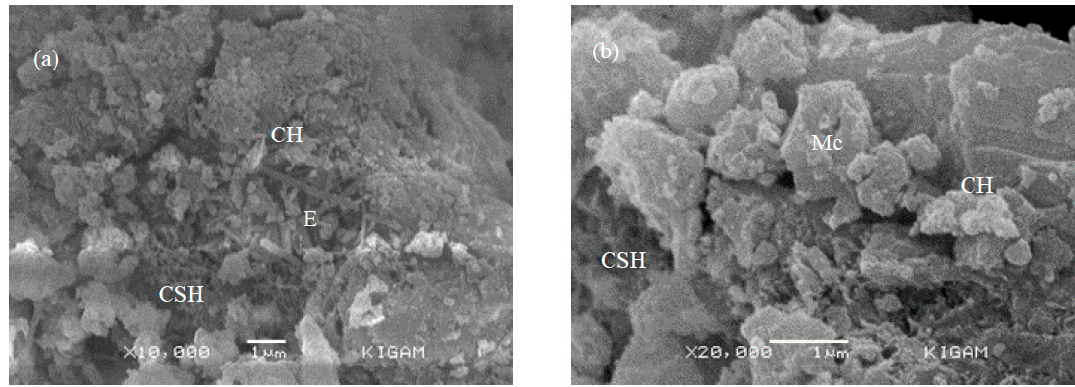
Figure 12. SEM image of ( a ) ordinary Portland cement (OPC) and ( b ) samples containing ESP.